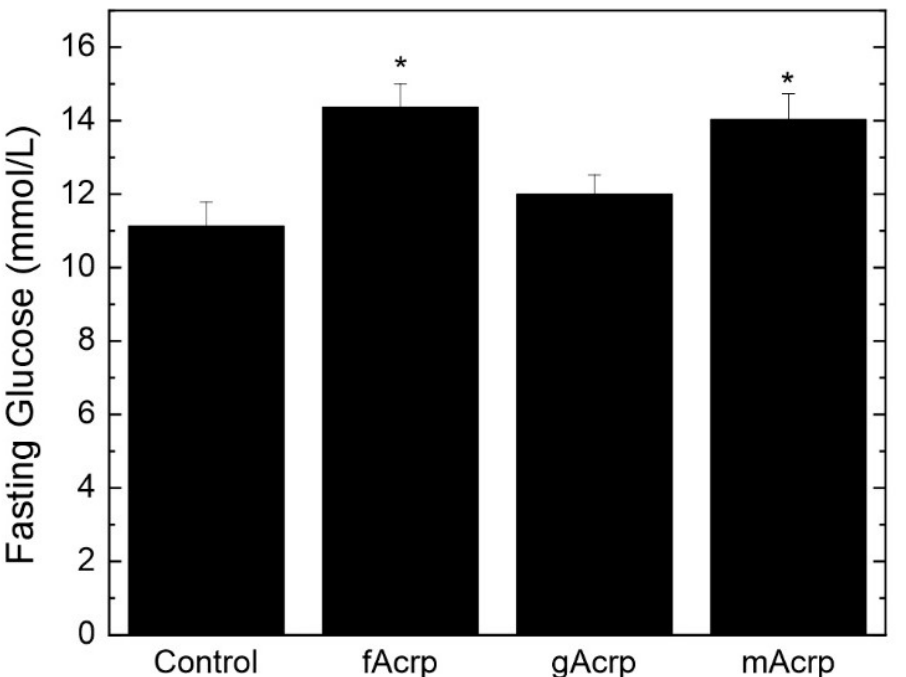
Figure 7. Comparison of fAcrp and gAcrp on fasting glucose levels. Tail vein blood glucose concen- trations were measured with an Alpha TRAK blood glucose monitoring system and glucose strips. The values are presented as mean ± sem from n = 10 animals per group. * p < 0.05 relative to Control as determined by ANOVA and Duncan’s multiple range test.